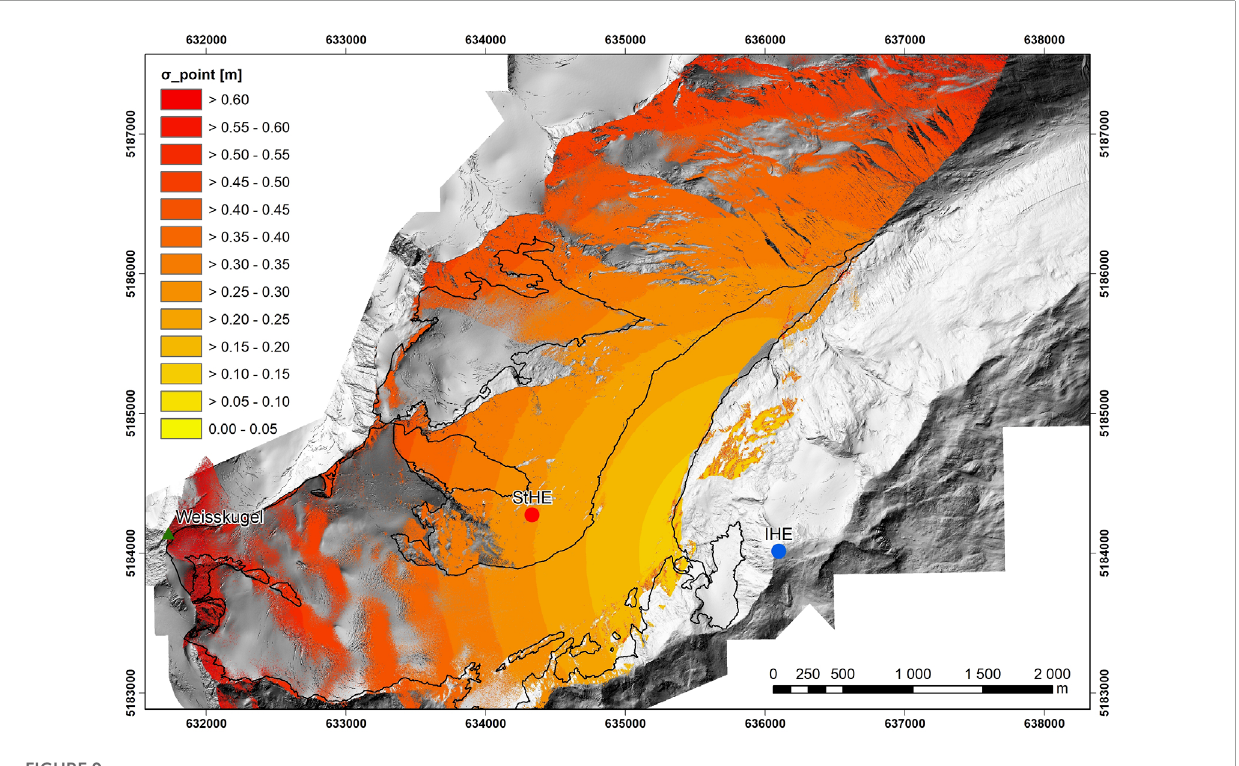
FIGURE 9 Uncertainty of a single laser pulse distributed over the glacier ( σ point ) .